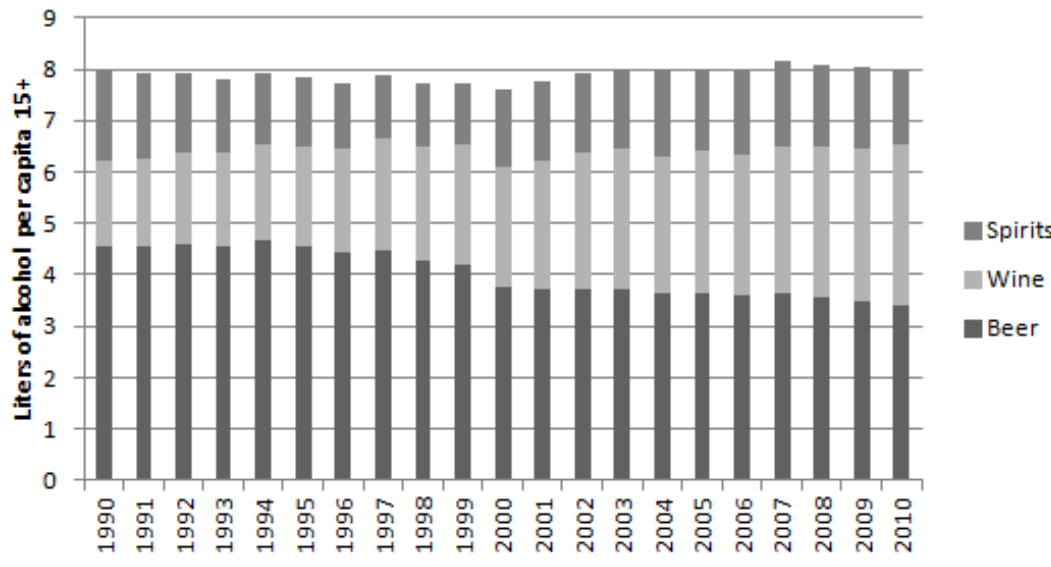
Source: WHO 2014, The World Bank